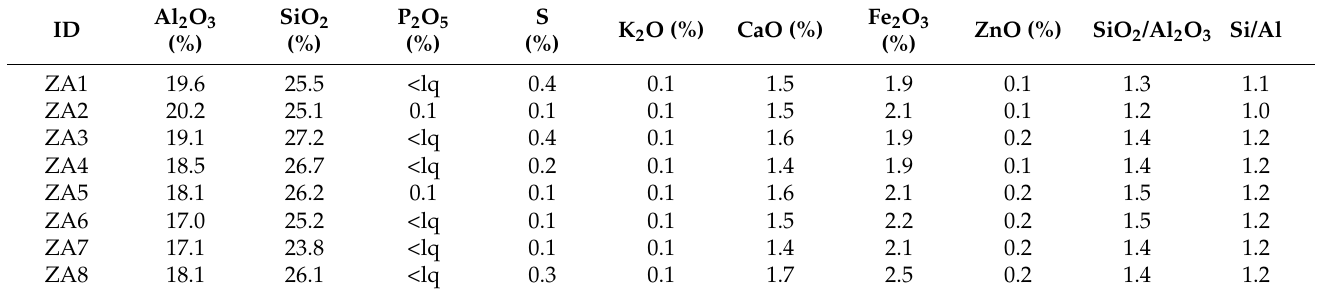
Table 3. Chemical composition of the synthesized LTA zeolites determined by X-ray fluorescence (XRF)